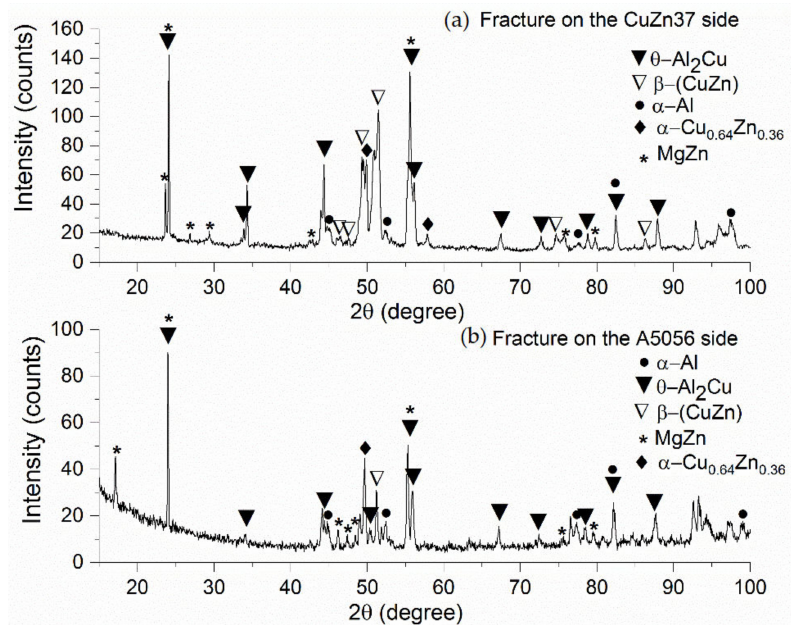
Figure 12. XRD diffractograms of fracture surfaces obtained after adhesion test on CuZn37 ( a ) and AA5056 ( b ).